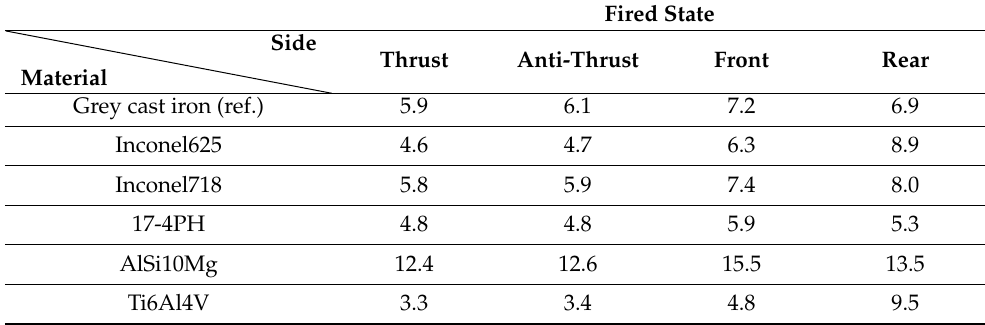
Table 4. Straightness deviation of the liner in µ